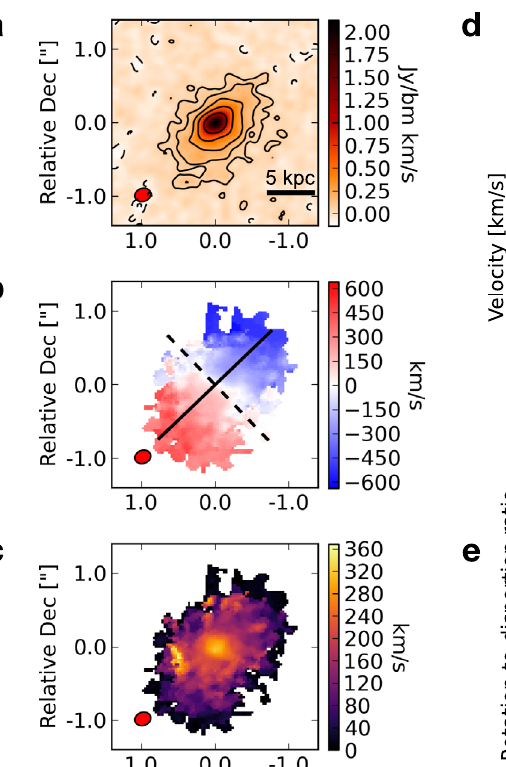
studyofthe3DdistributionofgasaroundW0410-0913inMethods).Thethree- dimensional distribution of gas around galaxies in the denser dynamic volume (with offset velocities in the range [ − 2.500; +1.500] kms − 1 ) is suggestive of connecting fi lamentarystructuresonscalesupto ≳ 100kpc(seewhiteandblack scales).